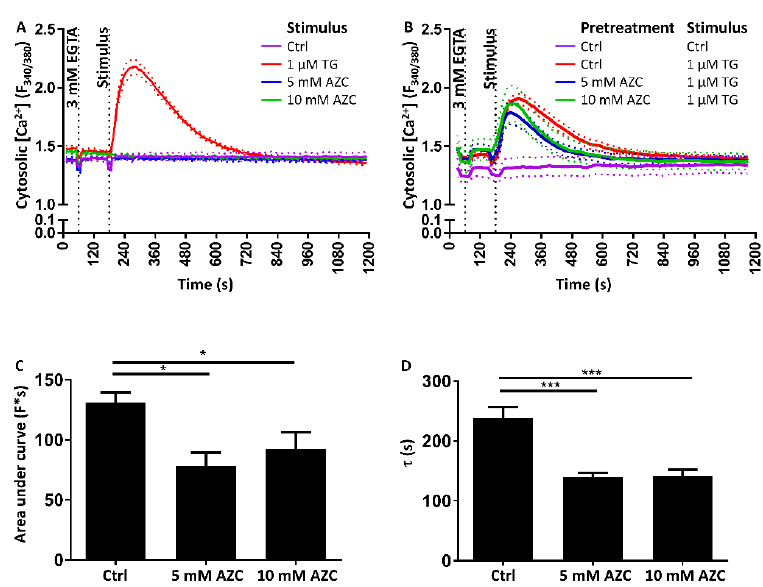
Figure 8. AZC does not acutely affect cytosolic Ca 2+ but pretreatment with AZC reduces the Ca 2+ amount detected in the cytosol after ER Ca 2+ store release evoked by thapsigargin (TG). Results are shown as mean ± SEM (indicated by the dotted lines) of three independent experiments each performed in duplicate. ( A ) Cells were loaded with 1.8 µ M Fura-2 AM for 30 min, followed by 30 min of deesterification. Fura-2 AM fluorescence was monitored using a FlexStation 3 microplate reader. Extracellular Ca 2+ was chelated with 3 mM EGTA and 120 s later AZC or 1 µ M TG (as a positive control) was added as indicated. ( B ) Cells were pretreated for 6 h with 5 mM or 10 mM AZC. During the last hour of treatment, cells were loaded with 1.8 µ M Fura-2 AM for 30 min, followed by 30 min of deesterification. Extracellular Ca 2+ was chelated with 3 mM EGTA and 120 s later 1 µ M TG or Krebs solution (vehicle) was added as indicated. ( C ) Quantification of the area under the curve of the Ca 2+ traces in ( B ) * p < 0.05. ( D ) Time constant τ for the decline phase of the Ca 2+ traces in ( B ) *** p < 0.001.